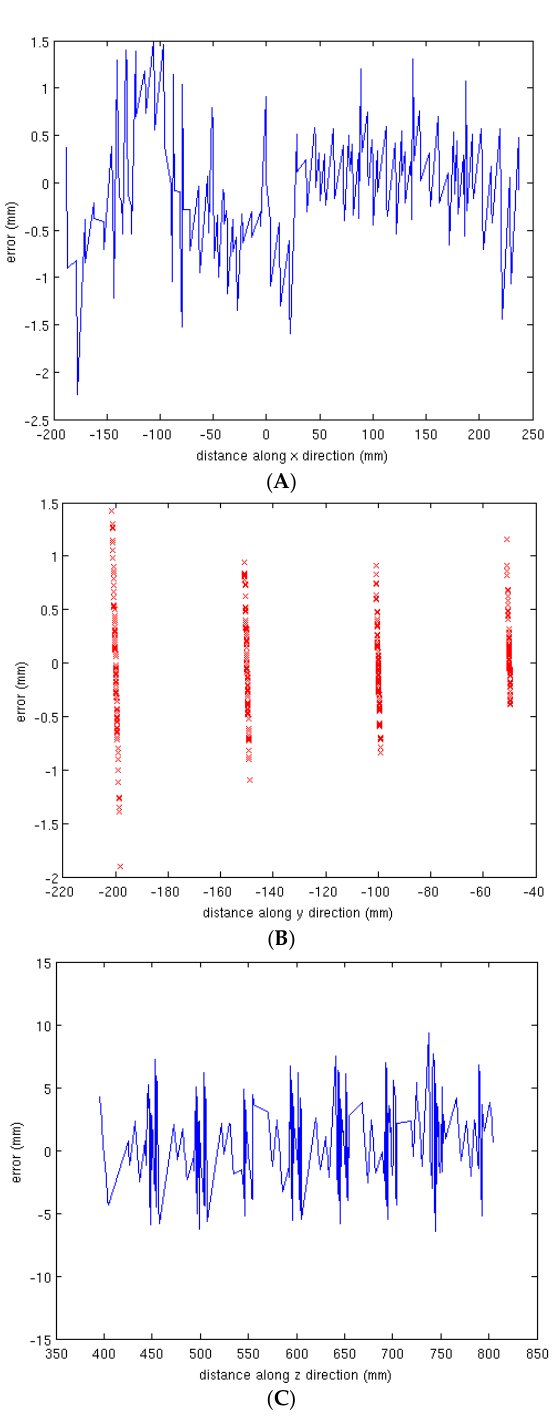
Figure 4. Error plots in X , Y , and Z direction. ( A ) errors in x direction; ( B ) errors in y direction; ( C ) errors in z direction.